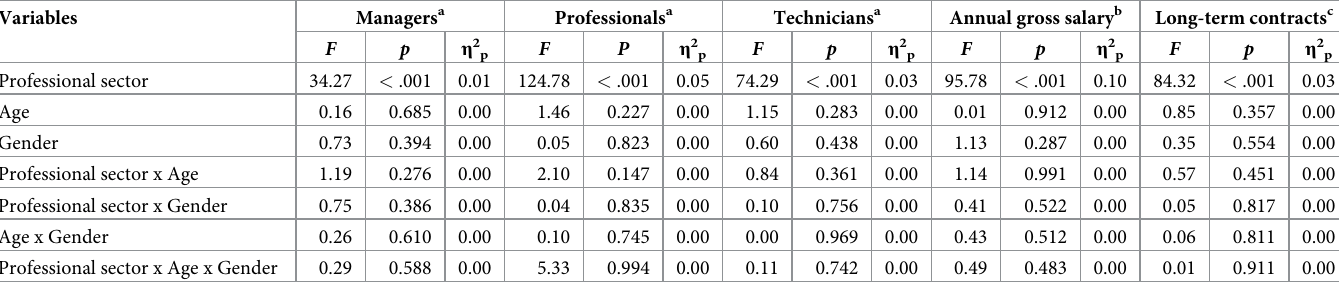
Table 3. ANOVA on the number of job offers received as a function of occupation categories, annual gross salary and number of long-term contracts. Variables Managers a Professionals a Technicians a Annual gross salary b